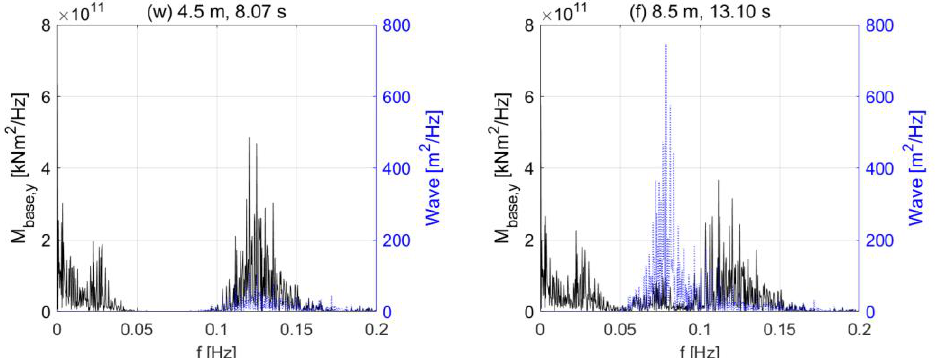
Figure 13. FFT results of tower-base pitch moments (black) and waves (blue) according to sea conditions.